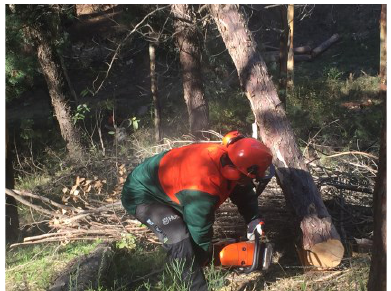
Figure 1. Tree felling task.